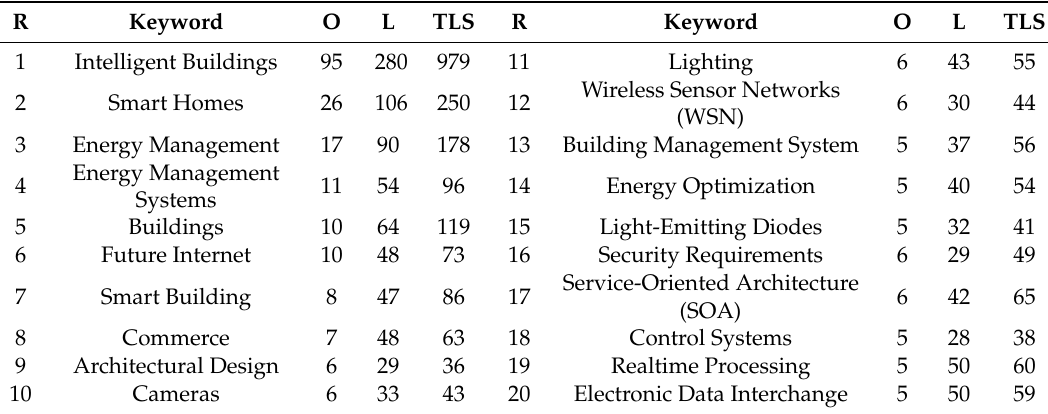
Table 10. Cluster 7: Top 20 keywords